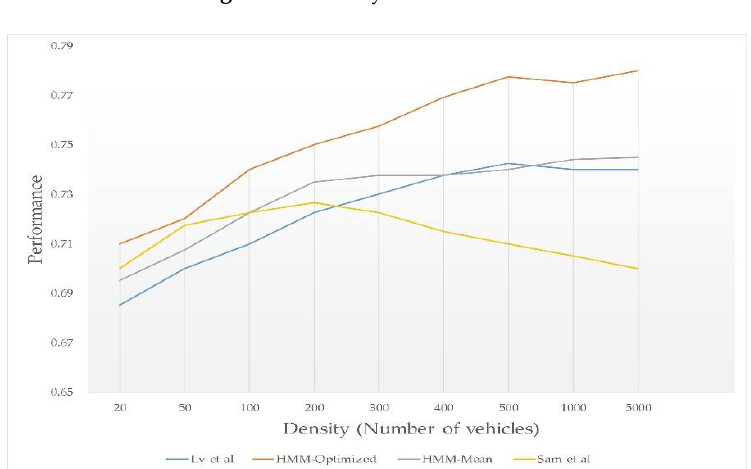
Figure 11. Density versus Precision.